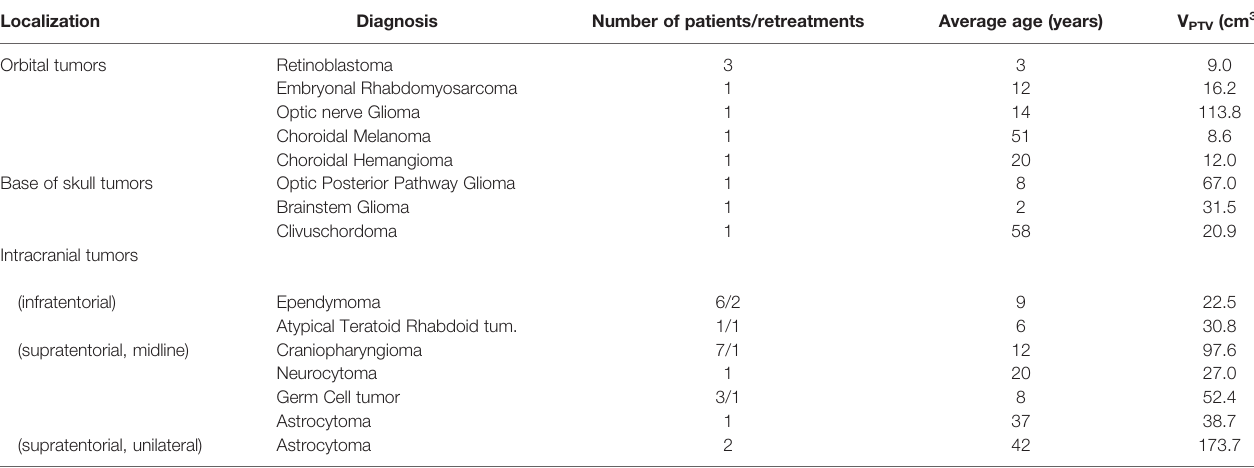
TABLE 2 | Overview of all cases which were treated with PBS-with-apertures and which were evaluated in the current study.